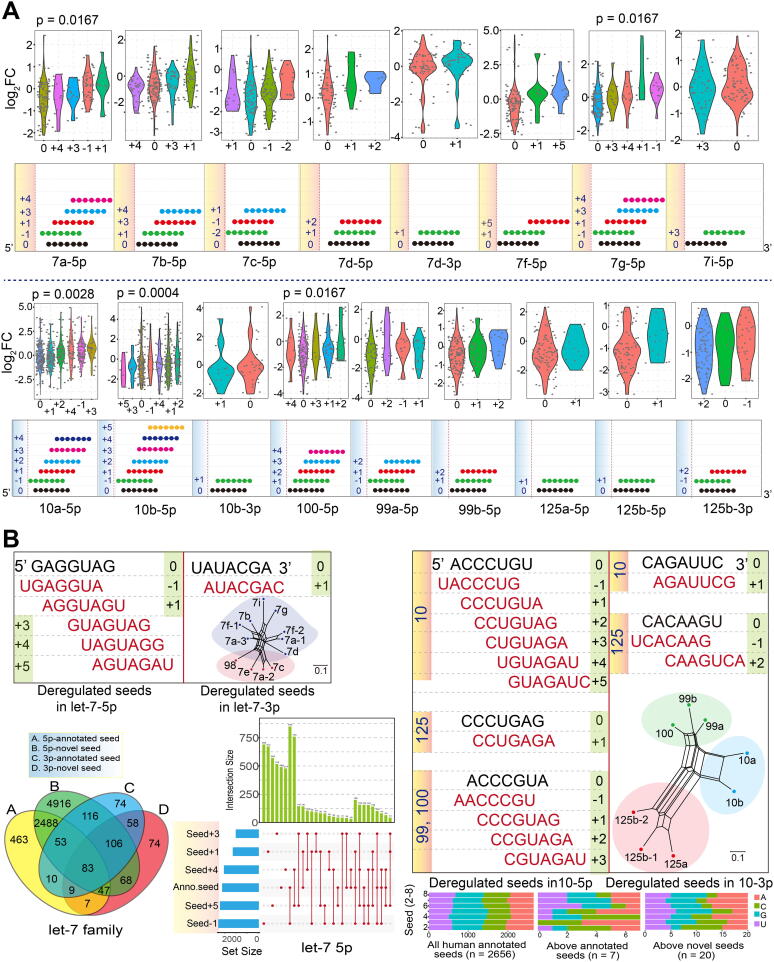
Seed variation among isomiRs. (A) Seed variations (annotated seed ± 5 nucleotides) and their deregulated expression patterns based on each miRNA locus. For multiple miRNAs, miRNAs are selected only if they had more isomiR types to avoid repeated estimation. Deregulated expression is estimated based on all relevant cancer types. If an isomiR shows decreased expression level, it will be removed from this analysis. miRNA loci are eliminated if no variations in the seed sequence are detected. (B) Detailed screening of deregulated seed sequences from the two miRNA gene families (a seed was is included if the corresponding isomiR is abnormally expressed in at least one cancer type), and distributions of predicted target mRNAs of annotated and novel seeds.